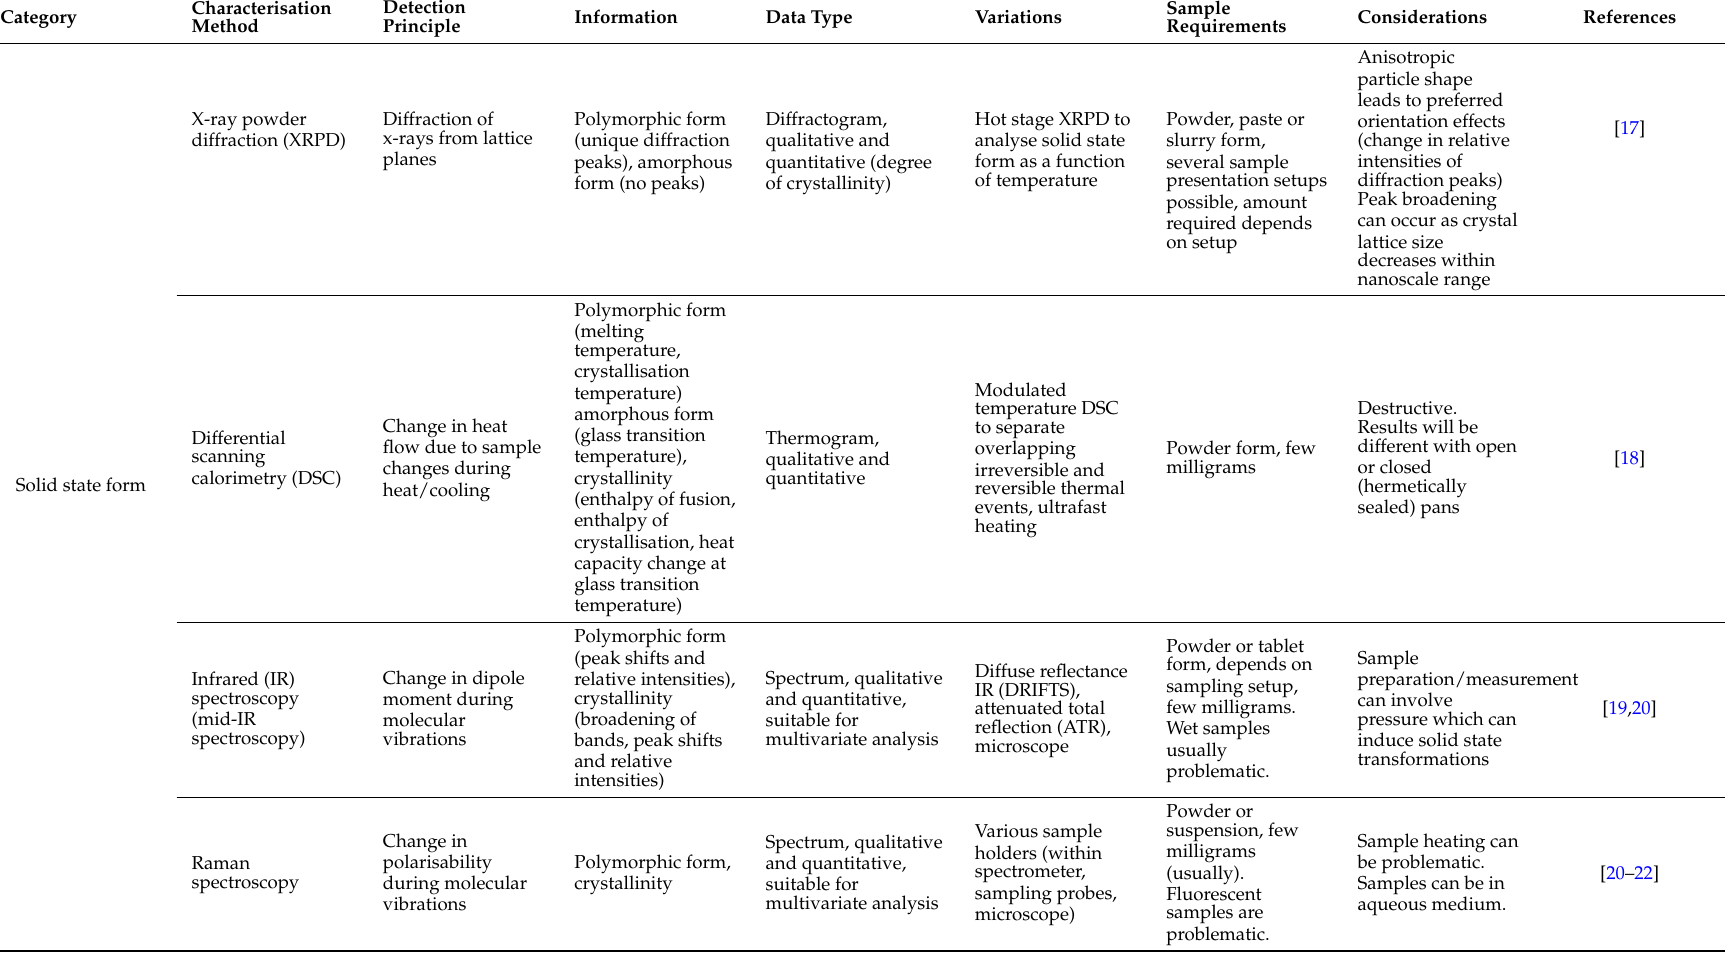
Table 1. Commonly used and more recent methods for characterising